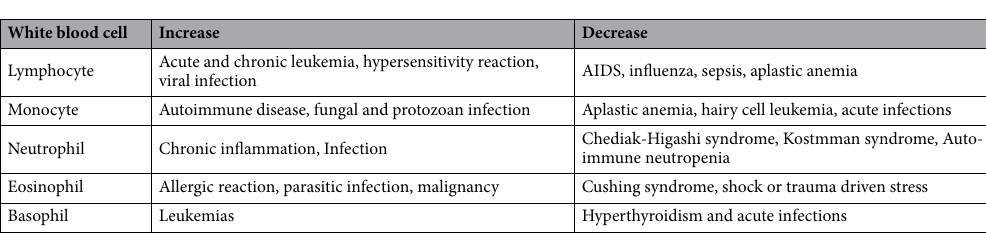
Table 2. White blood cells alterations and related different diseases 5